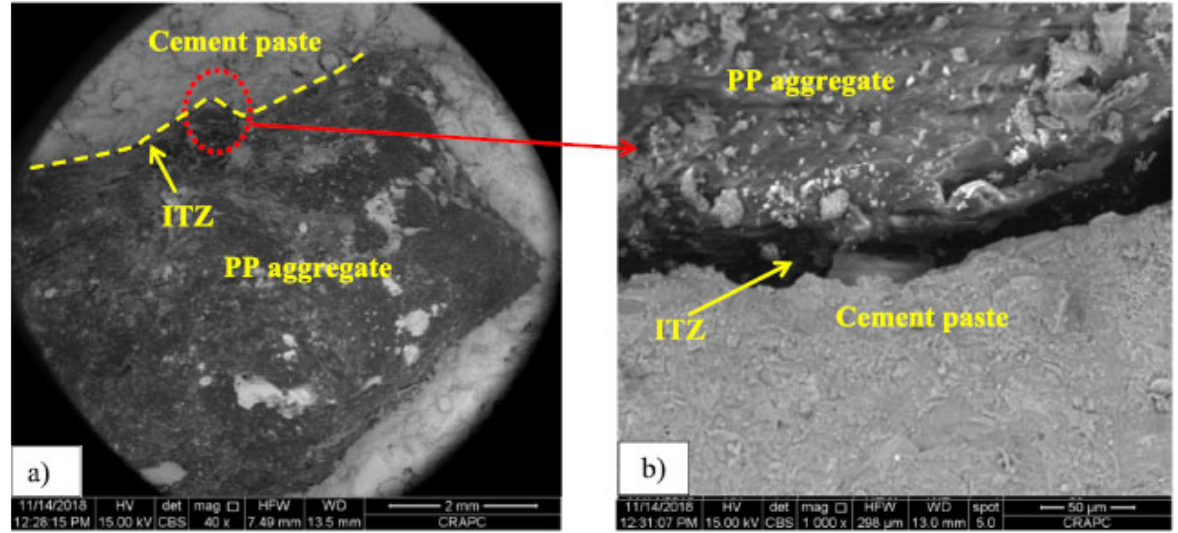
Figure 14. Scan Electronic Microscopy Plastics Waste Aggregate: Used as per Elsevier Permission [92].